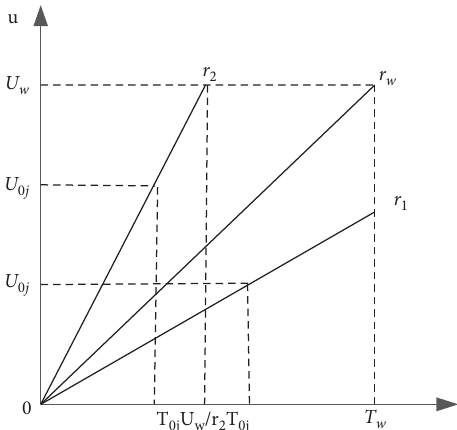
Figure 4: Warranty period corresponding to different utilization